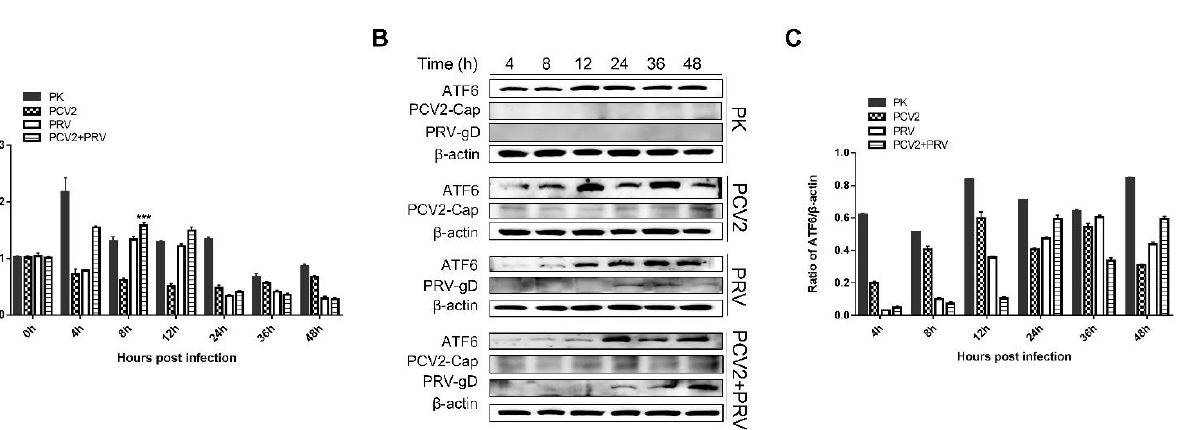
Figure 5. ATF6 pathway was inactivated during PCV2 and PRV single- and coinfection. PK-15 cells were single- or co-infected with PCV2 and/or PRV for 4, 8, 12, 24, 36, and 48 h. The expression levels of ATF6 were assessed by real-time PCR ( A ) and Western blotting ( B ). β -actin was used as a control. The relative amount of target protein to β -actin was quantified by densitometry analysis using ImageJ software ( C ). ***, p -value < 0.001. ATF6 (Wanleibio, Shenyang, China, 1:1000), PRV-gD (Lvdu, Shandong, China, 1:500), PCV2-cap [31], and β -actin (Proteintech, Wuhan, Hubei, China, 1:10,000) were used as primary antibodies, respectively. Unprocessed original images can be found in Supplementary Figure S2.